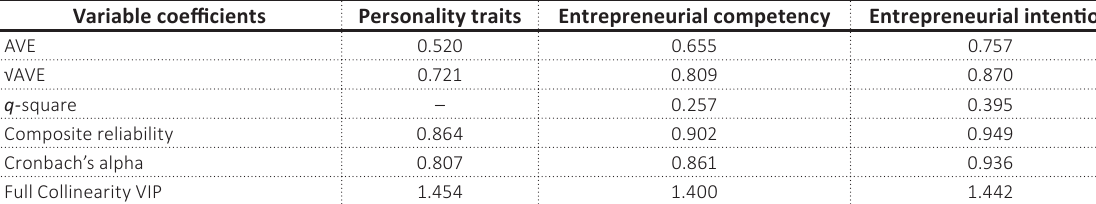
Table 3. Validity and reliability of the